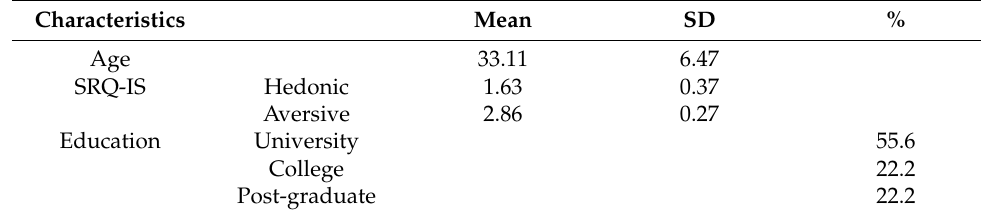
Table 1. Sample characteristics (mean, SD, percentage) (N = 10).